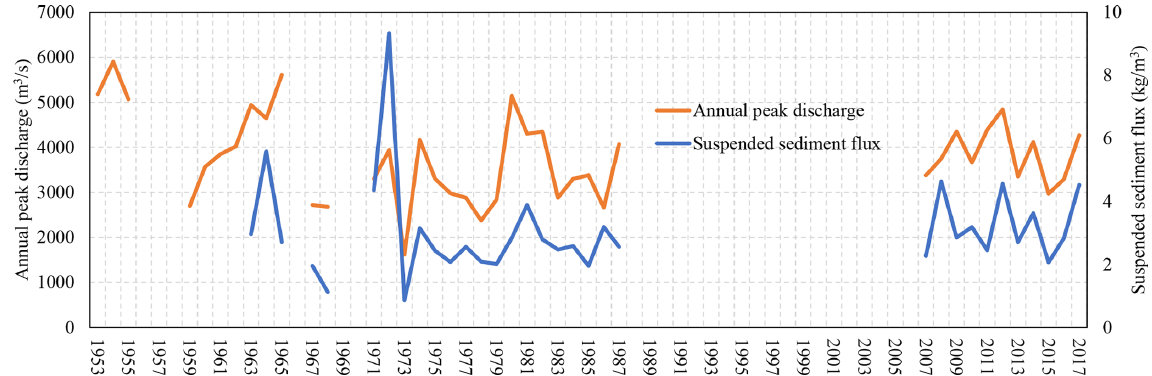
Figure 2. Multiyear peak discharge and suspended sediment flux at the Batang station. For comparison, the discharges for the 2018 Baige floods were 7850 and 21200m 3 s − 1 , respectively, and the suspended sediment fluxes were 21.6 and 42kgm 3 , respectively. Note multiyear gaps in the available data, which are partly due to the remoteness of the station. Despite the gaps, any event with a discharge larger than those in 1954 would be recorded.